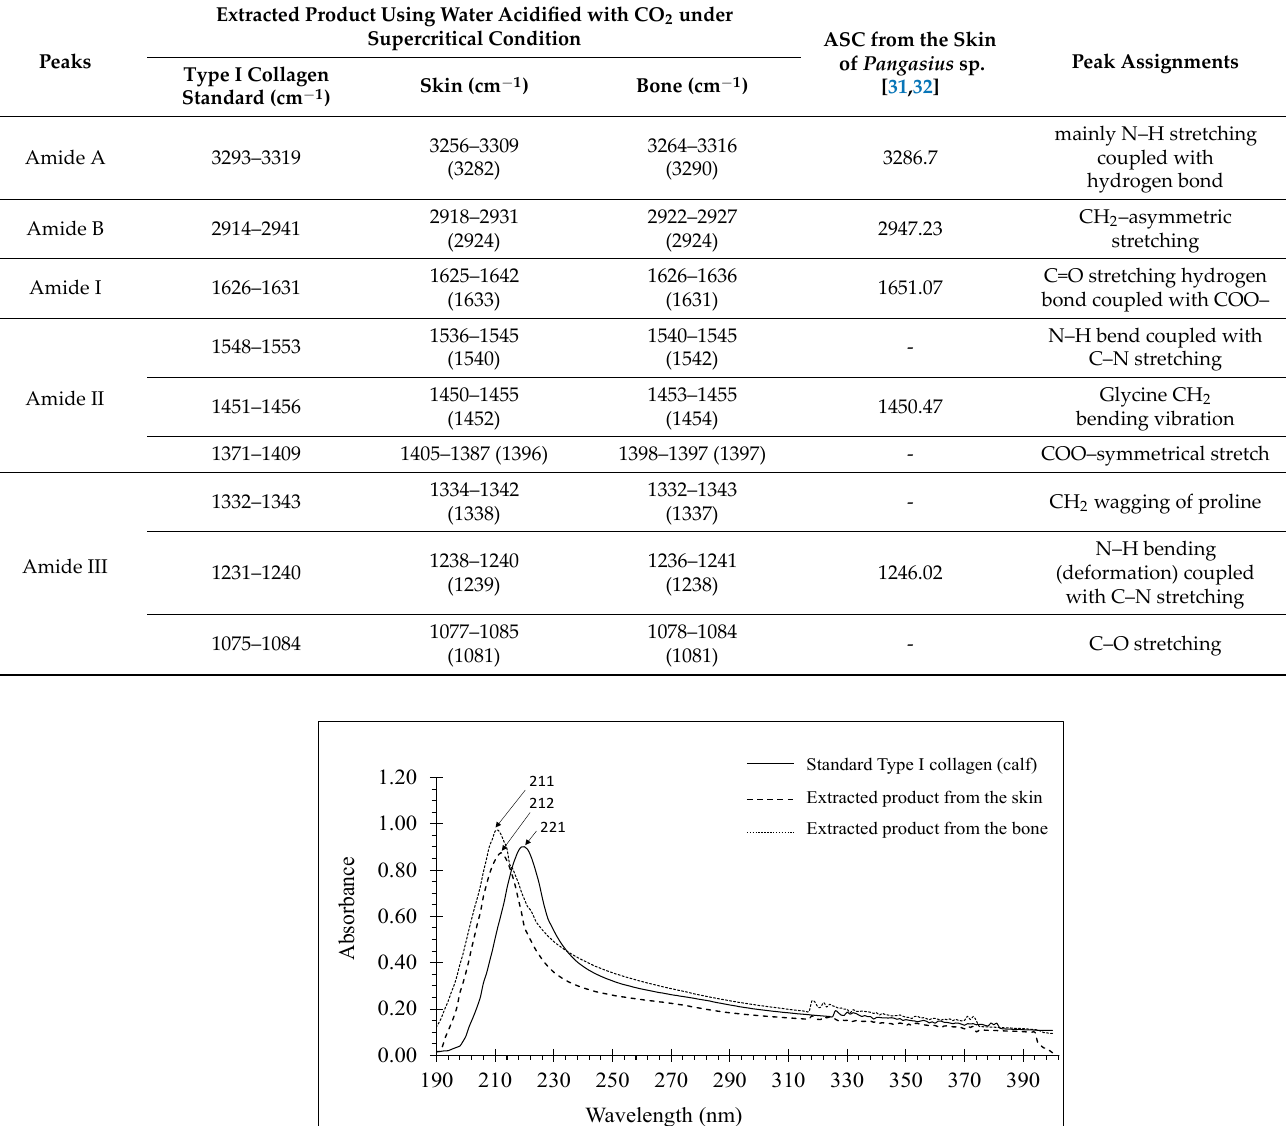
Table 5. FTIR spectra range locations of Type I collagen standard and peak locations of the extracted product from the skin and bone of striped catfish ( Pangasianodon hypophthalmus ).